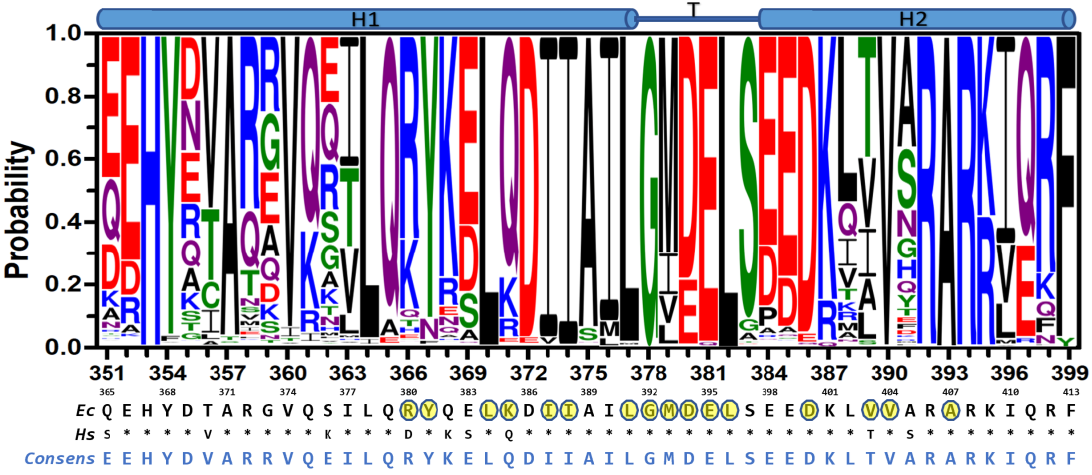
Figure 6. Conservation of the HTH motif in bacteria. Residue numbering in the up and down rows corresponds to the E. coli and human sequences, respectively. Multiple sequence alignment of 23,125 entries was performed with Clustal Omega [59]. Logos were generated using the Weblogo3 server [58]. Consensus, E. coli ( Ec ) and human ( Hs ) sequences are shown in the x-axis for comparison. Human residues identical to E. coli residues are shown with asterisks. The Conserv row corresponds to a conservation scale ranging from 0 (null conservation) to 10 (= +, complete conservation of physicochemical properties of the amino acid group) as defined in [62]. Residues within 5 Å of Compd-5 are highlighted in yellow.